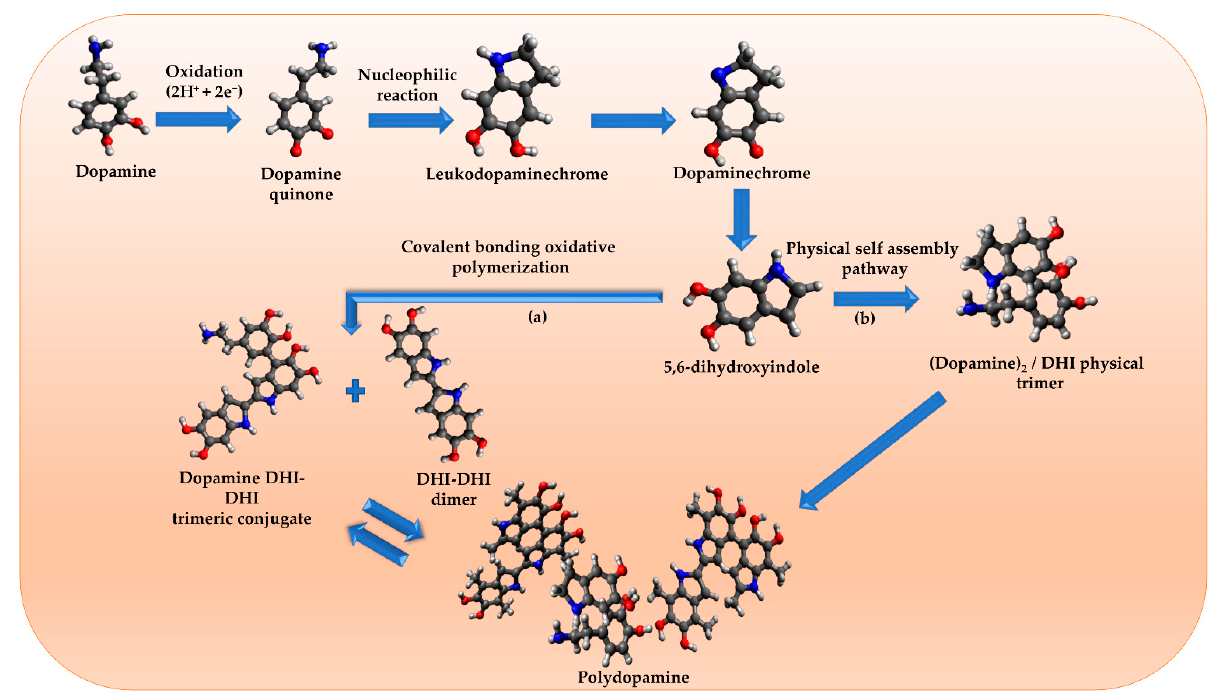
Figure 6. The two pathways applied for polydopamine polymerization, ( a ) covalent bonding oxidative polymerization and ( b ) physical self-assembly.